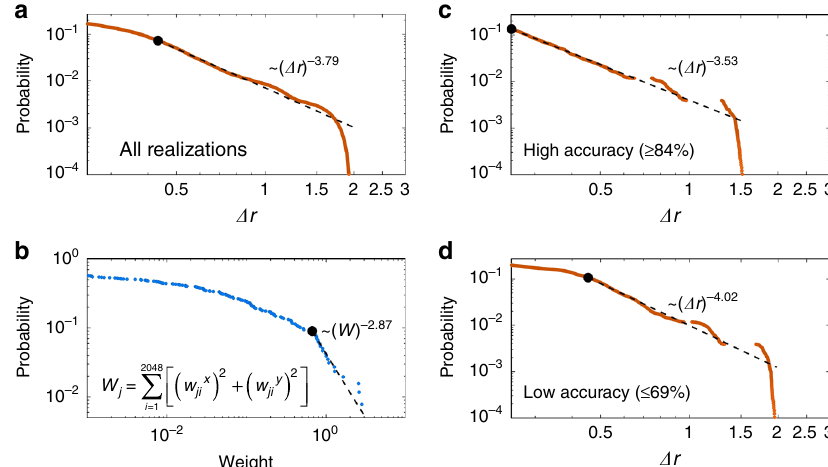
Fig. 5 Scale invariance in machine-learning-generated disordered structures and neural network structures. a Power-law fi tting of the statistical distribution of Δ r in machine-learning-generated disordered structures, which is the same fi gure with Fig. 4g-1 and is shown for comparison. b Power-law fi tting of the statistical distribution of the weight strength parameter W j . c , d Power-law fi tting results of the realizations for c high ( ≥ 84%) and d low ( ≤ 69%) test accuracies. All of the fi tting results are based on the same method using in Fig. con fi rming the reliability of the power-law fi tting and the observed scale-free invariance.